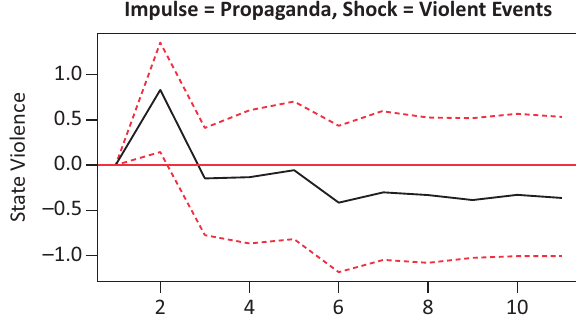
Figure 3. Impulse response function of propaganda on state violence,